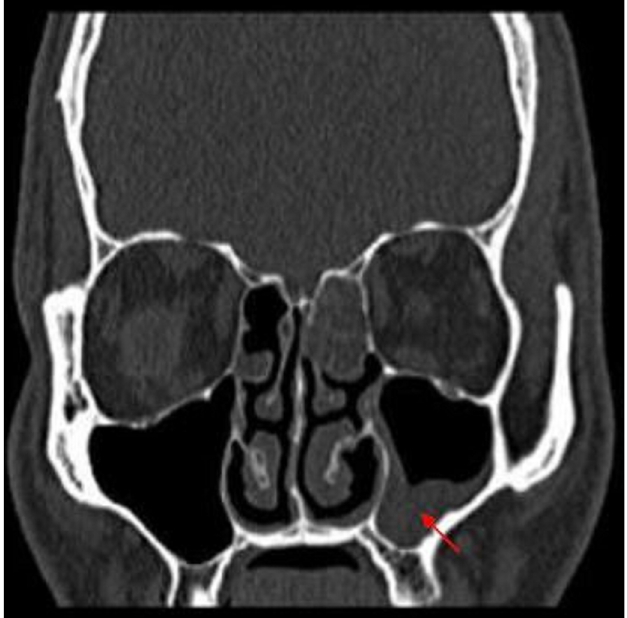
Fig. 6. Preoperative coronal CT image showing unilateral mucosal thickening in the base of the maxillary sinus on left side (arrow).